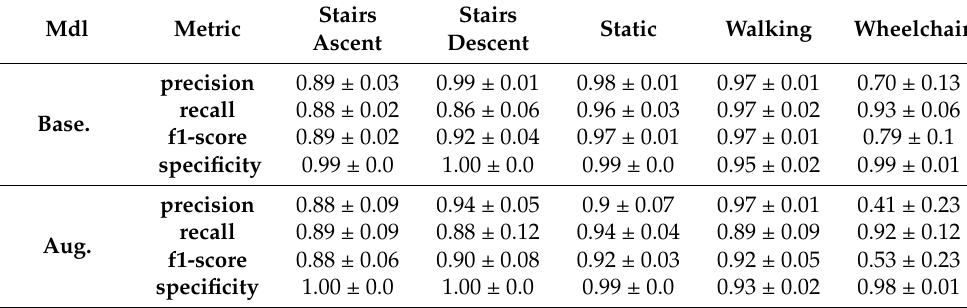
Table A3. Single class results of baseline and augmented model for the original test set. Considered data: WPS holdout